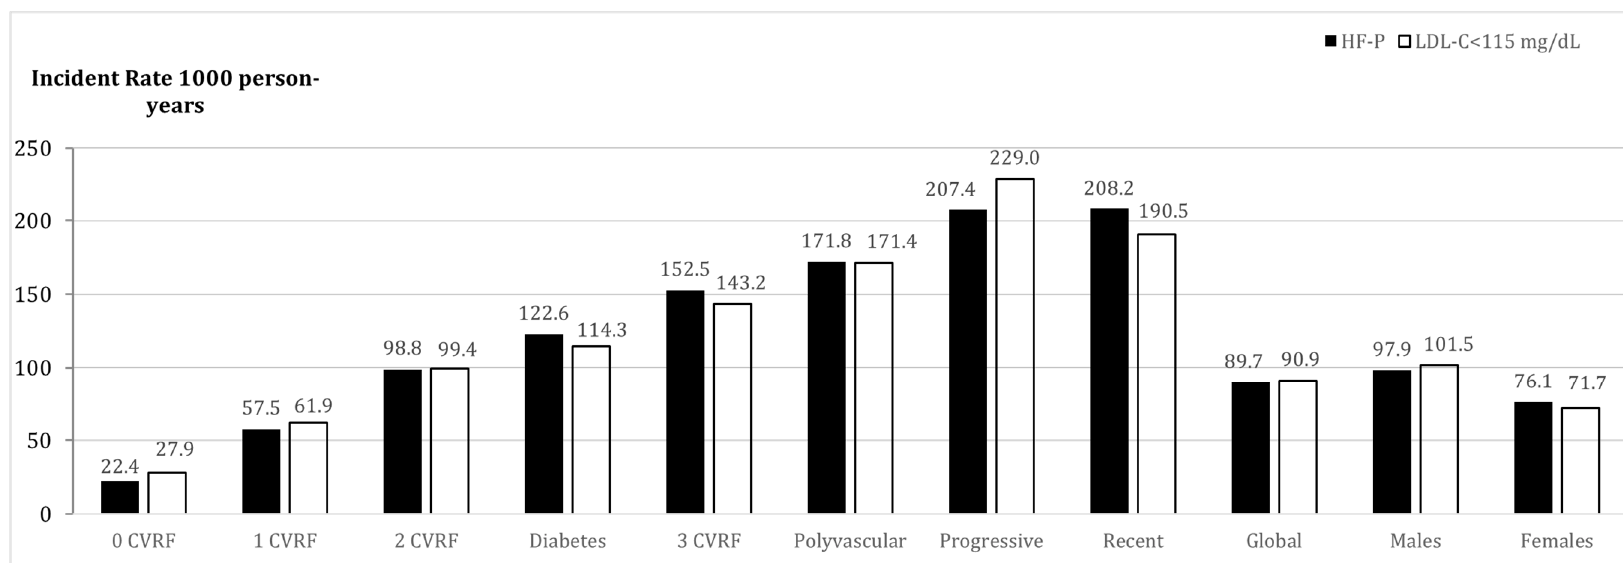
Figure 4. Incidence rate (per 1000 person-years) of ASCVD in secondary prevention in FH-P vs. normolipidemic population based on the presence of number of cardiovascular risk factors and clinical associated characteristics. ASCVD: Atherosclerotic Cardiovascular Disease; CVRF: Cardiovascular Risk Factor; HF-P: Familial Hypercholesterolemia; CLDL: Cholesterol-LDL.